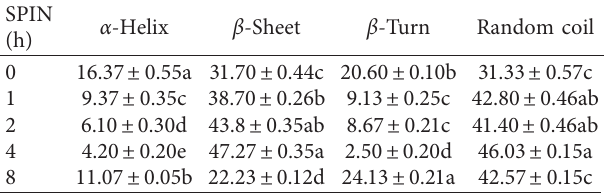
Table 3: The secondary structure compositions of SPIN. SPIN α -Helix β -Sheet β -Turn (h)